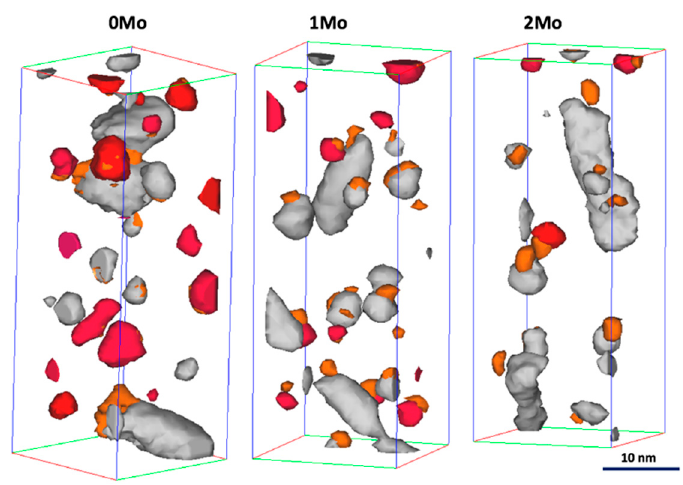
Figure 4. APT reconstructions after aging at 475 °C for 40 h. Cu-rich precipitates are shown in orange, Ni-rich precipitates containing more than 5 at.% Si ( γ ' or G) in red and less than 5 at.% Si ( η ) in grey.